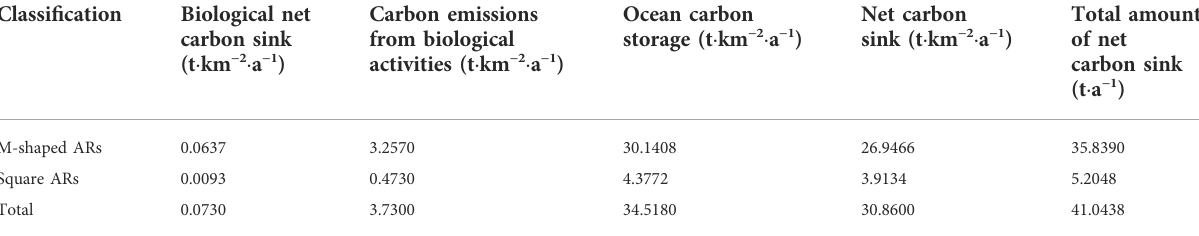
TABLE 7 Results of carbon emissions and carbon sinks for Juehua Island